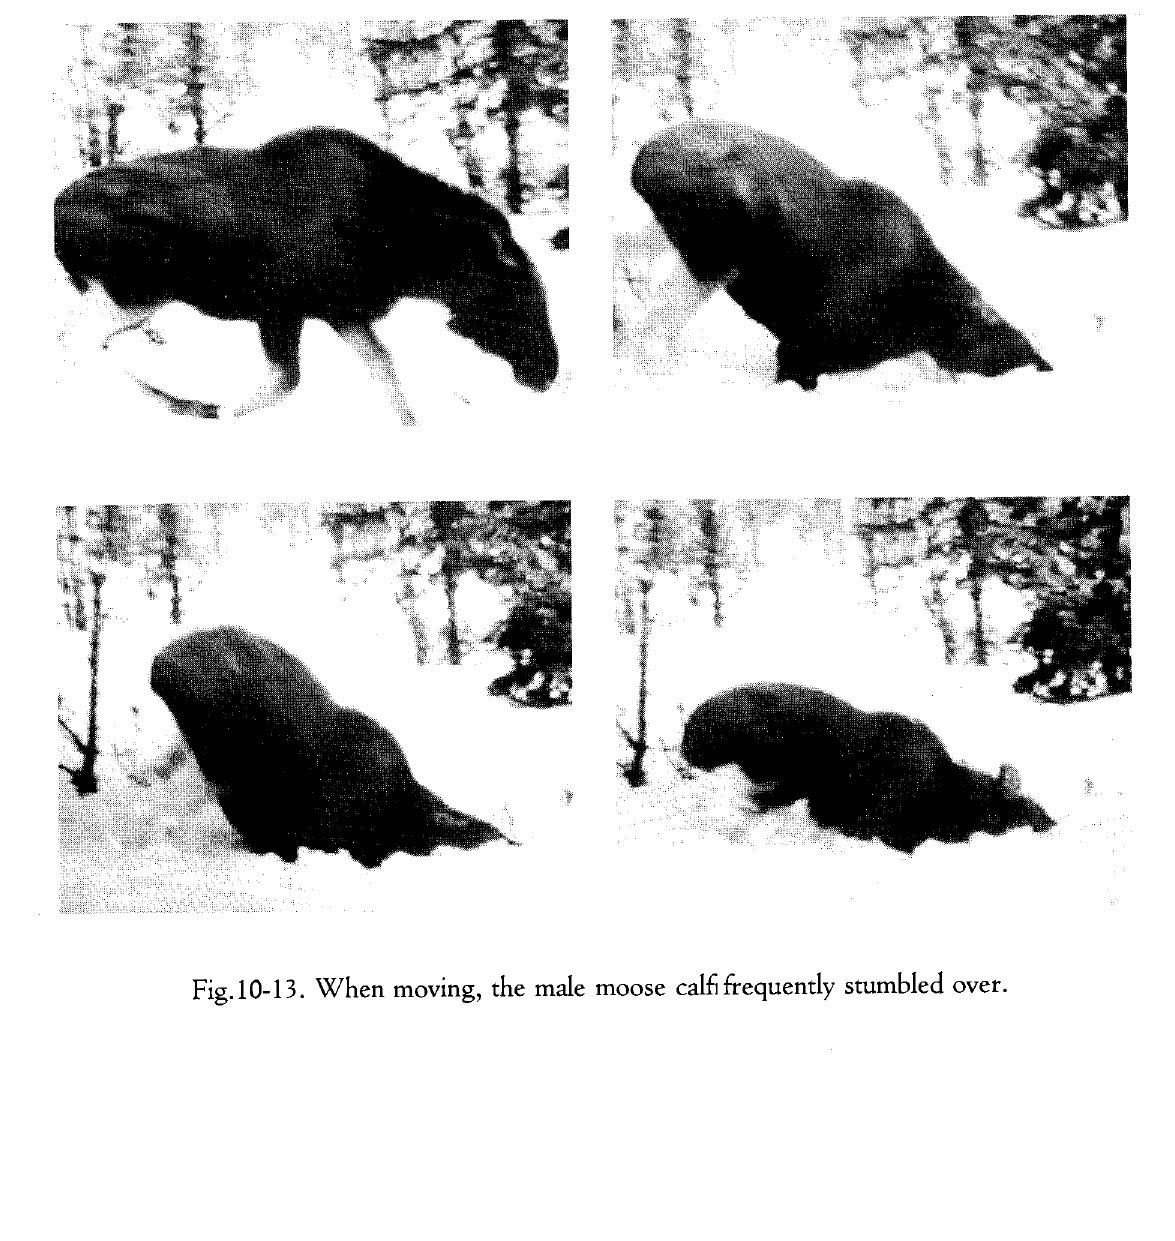
Fig. 10-13. When moving, the male moose calf frequently stumbled over.